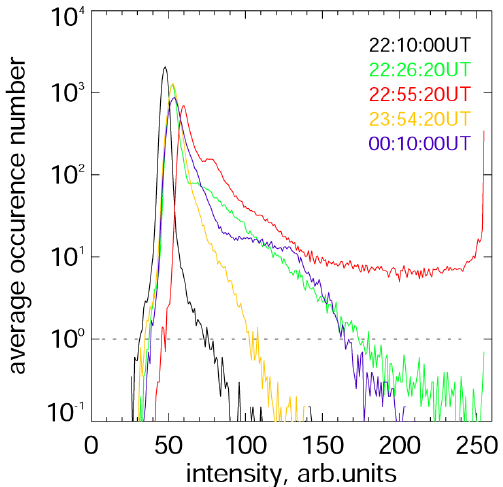
Fig. 2. Occurence number of pixels vs. auroral intensity averaged in 20-s intervals, beginning from the marked time. 1-pixel occurence level is shown by dashed